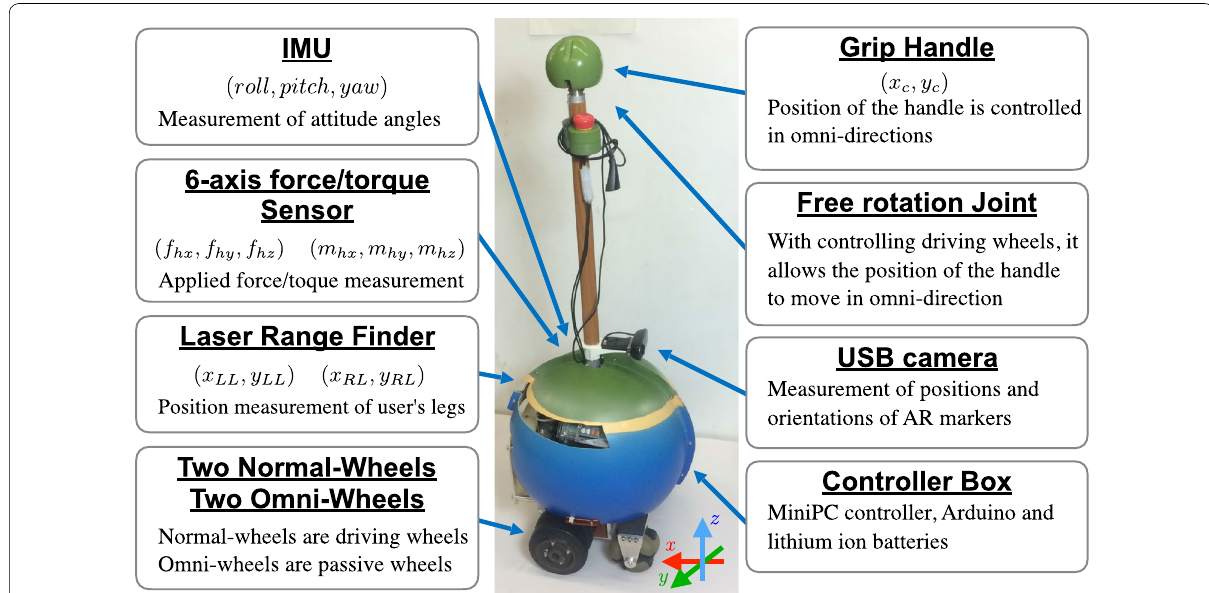
Fig. 1 Intelligent Cane ver.6. Components description of our cane-type robot used in this paper. This robot is designed to be capable of active movement, e.g., user